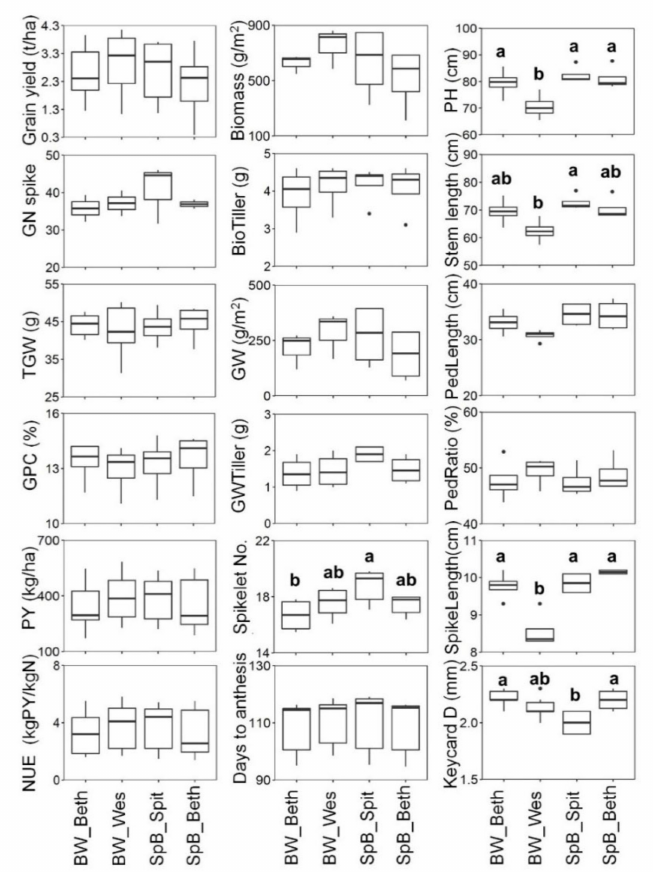
Figure 1. Box plots of yield-related traits of three parental lines in BW and SpB populations. GN: grain number; TGW: thousand grain weight; GPC: grain protein content; PY: protein yield; NUE: nitrogen use efficiency; Biomass: plant biomass per m 2 ; BioTiller: biomass per tiller; GW: grain weight; GWTiller: grain weight per tiller; Spikelet No.: spikelet number per spike; PH: plant height; PedLength: peduncle length; PedRatio: peduncle ratio; Keycard D: keycard diameter; Beth: Bethlehem; Wes: Westonia; Spit: Spitfire. Values with the same letter or without letter are statistically not different at p =